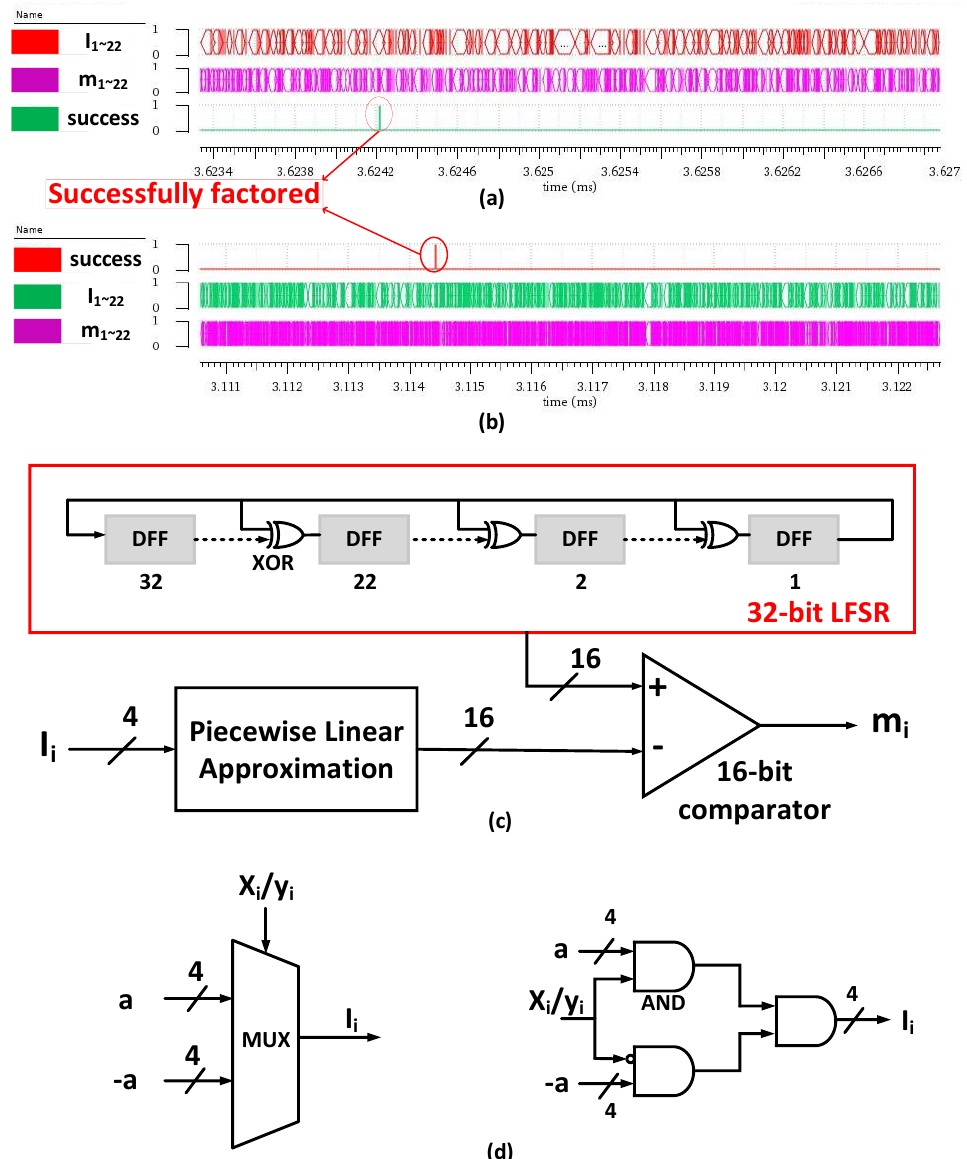
Figure 7. Examples of factoring 24-bit integers 14019841 ( a ) and 14166761 ( b ) using Vivado. 𝑚 10~1 and 𝑚 22~11 represent { 𝑥 10 ,…, 𝑥 1 } and { y 10 ,…, y 1 }, respectively. The clock period in this front-end circuit simulation is 500 ns. ( c ) Schematic view of CMOS-based stochastic Ising spin. It comprises a 32-bit LFSR, a piecewise linear approximation module, and a 16-bit comparator. The behavior of the CMOS-based stochastic Ising spin is the same as described in Equation (2). ( d ) Schematic view (left) and circuitry (right) of a digital MUX.